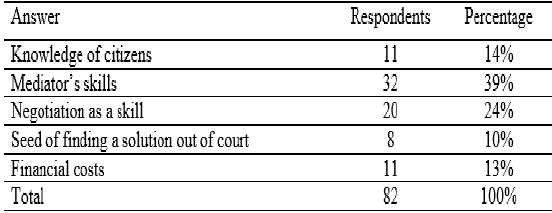
Table 8. Table of received answers to question number